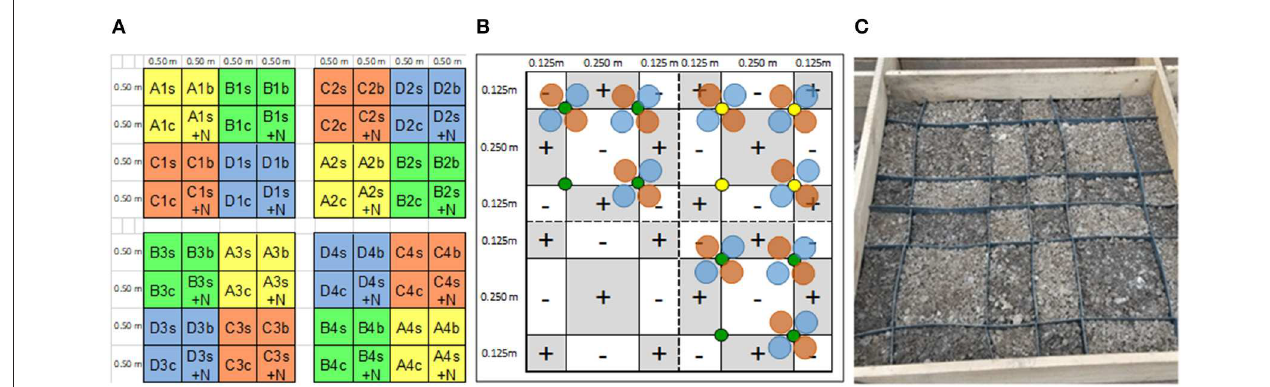
FIGURE 1 | Schematic view showing the layout of the P heterogeneity experiments at sites Achenpass and Mitterfels . (A) Distribution of the four treatment variants (A–D; capital letters; each covering four replicated 1 m ² squares); the four replicated blocks of each treatment variant (1–4), and the four 1 m ² subvariants (tree species: s, spruce; b, beech; + N: experimentally elevated N deposition; C: control) in each treatment variant. (B) Spatial arrangement of artificial soil heterogeneity in each 1 m ² treatment variant. Circles indicate planting positions of spruce (green) and beech (yellow) seedling. “ + ” and “–” compartments are filled with identical artificial soil material for the “homogeneous” experimental variants, and with different soil materials for the “heterogeneous” variants, separated by PVC walls. (C) Photograph of one 1 m ² tree species variant plot of the Achenpass experiment before being homogeneously covered with Ah horizon material.